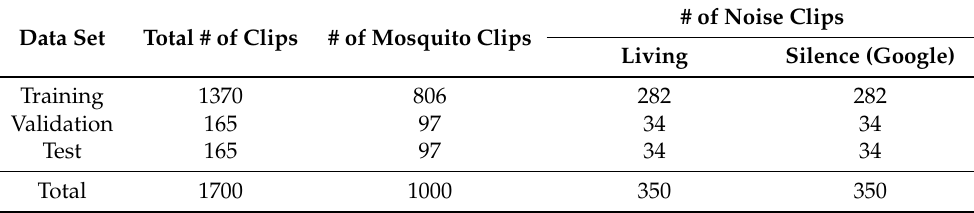
Table 1. Data set configuration for on-PC model development of the neural network that classified mosquito